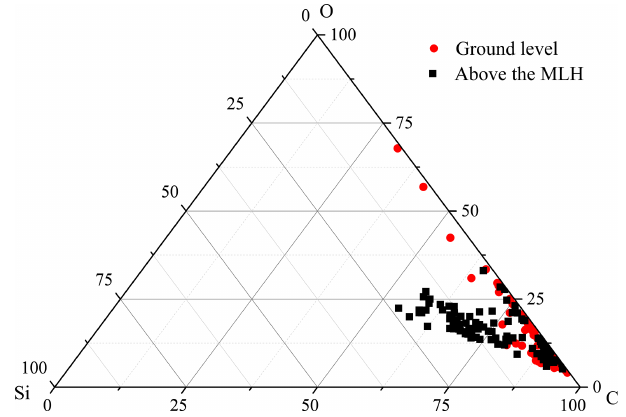
Figure 7. Triangular diagram showing the weight ratio of C–O–Si of primary organic aerosols (POAs) at ground level and above the mixed-layer height